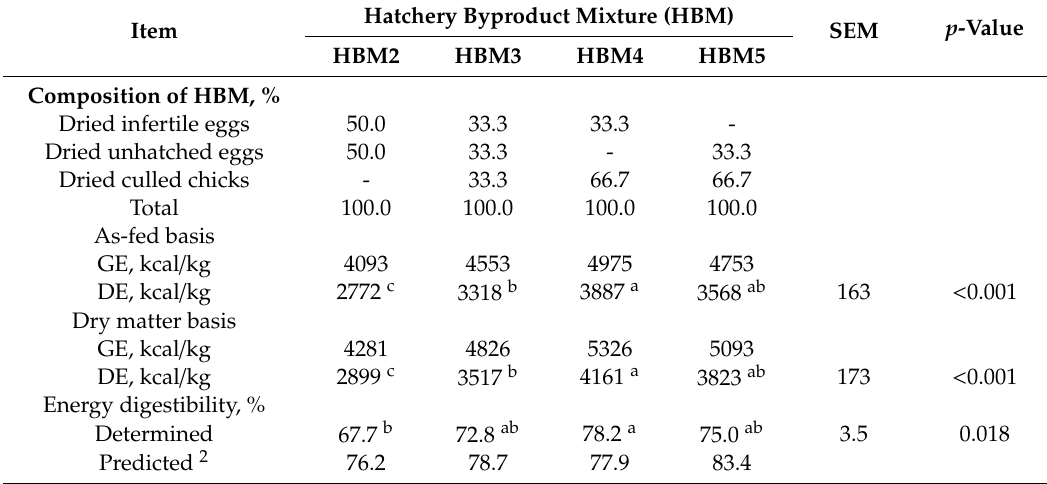
Table 6. Energy digestibility of hatchery byproduct mixtures fed to pigs 1